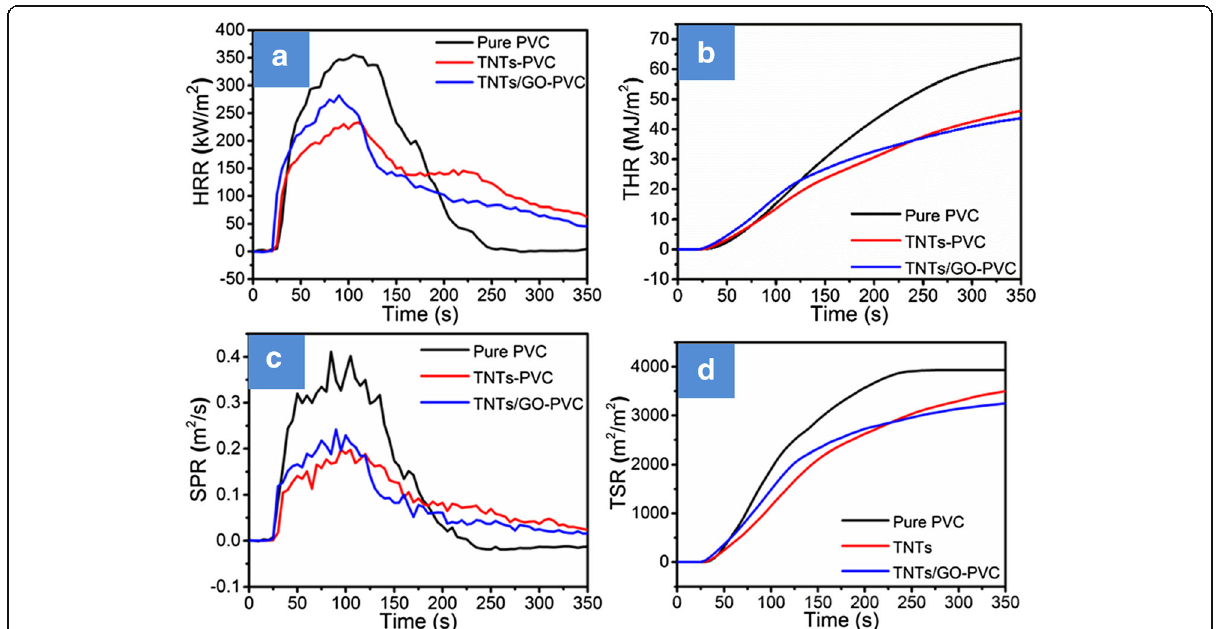
Fig. 7 HRR a , THR b , SPR c , and TSR d versus time curves of pure flexible PVC and PVC-matrix composites obtained from cone calorimetry test at 35 kW m − 2 . The HRR curve of TNTs-filled PVC contains a second peak around 230 s, which means that the char is unstable and can be destroyed easily. The TNTs/GO inhibited the second heat release peak, and with 2.5% content, the pHRR value is 282.4 kW m − 2 , a reduction by 20.5% in comparison with that of neat PVC. This indicates that the char on the surface of the TNTs/GO-filled PVC composites is very stable and can act as a physical barrier to hinder the transmission of heat